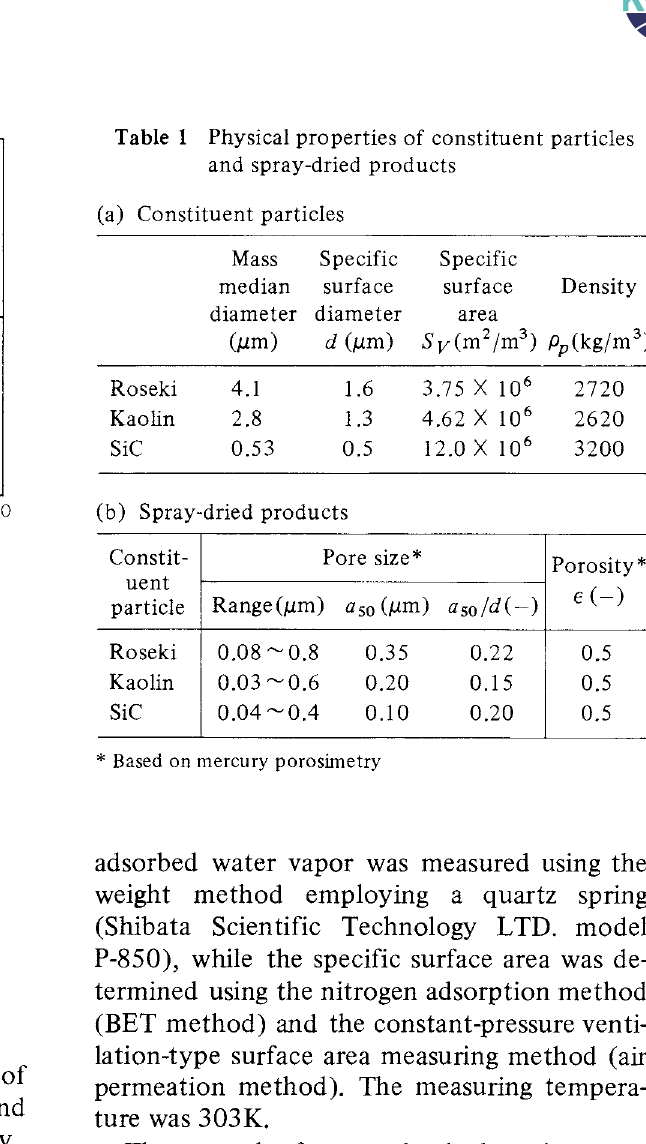
Fig. 2 SEM of spray-dried products